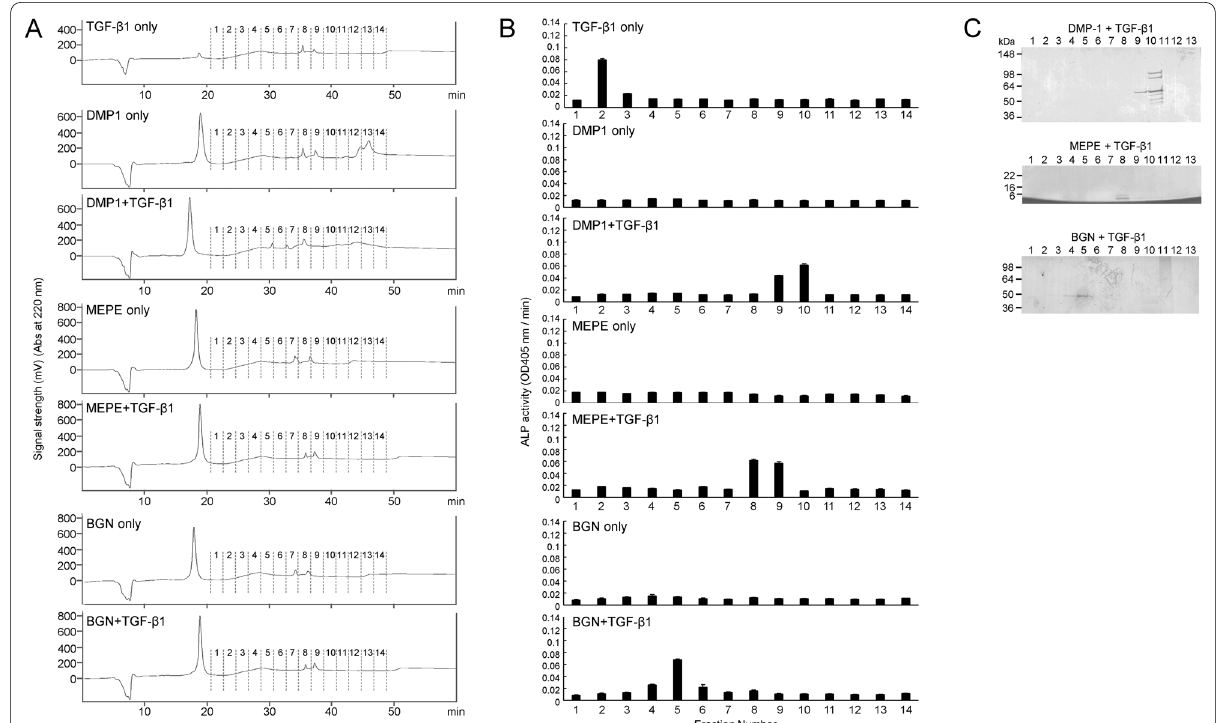
Fig. 5 In vitro binding study of CF‑hTGF‑β1 with CF‑hDMP1, CF‑hMEPE, and CF‑hBGN. A IE‑HPLC chromatograms showing absorbance at 220 nm. B ALP‑inducing activity of HPDL cells exposed to fractions 1 to 13 in each sample. CF‑hTGF‑β1 without incubation for the binding experiment (1 ng/ mL) was used as a positive control. Data are means SEs of 3 culture wells (* p < 0.05, Mann–Whitney U test). C SDS–PAGE (5–20% gradient gel) ± stained with silver showing CF‑hDMP1 (top), CF‑hMEPE (middle), and CF‑hBGN (bottom) after binding to CF‑hTGF‑β1 in fractions 1–13